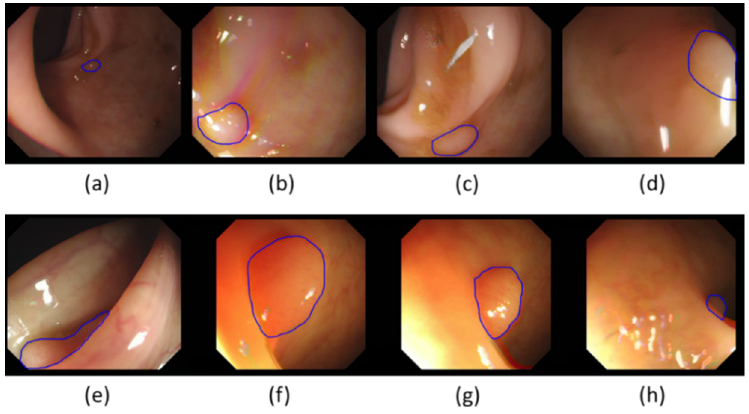
Figure 1. A sample of typical polyps from the GIANA SD (CVC-ColonDB) training dataset: ( a , h ) Small size. ( b ) Blur. ( c ) Intestinal content. ( d ) Specular highlights / defocused. ( e ) Occlusion. ( f ) Large size. ( g ) Overexposed areas. ( a , e , h ) Luminal